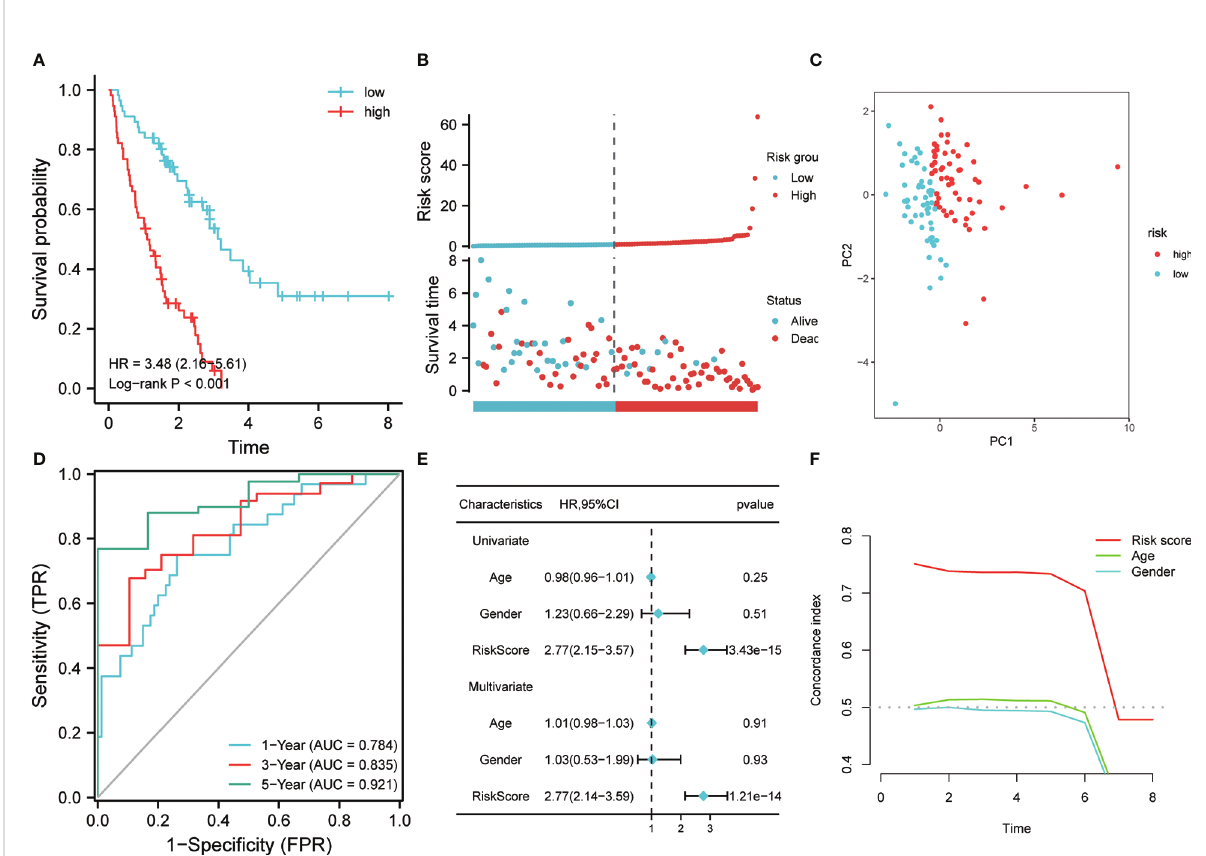
FIGURE 3 Prognostic value of risk model in the training cohort. (A) K-M method was used to draw the survival curve according to risk score, and for comparison, a log-rank test was employed. (B) The distribution of risk score and survival status between high and low-risk groups. (C) To evaluate the differentiation between groups with high and low risk, PCA was utilized. (D) Through ROC analysis, the predictive effect of the risk model in the training queue was evaluated. (E) Univariate and multivariate Cox analysis. (F) C-index analysis was used to evaluate the prediction ability of the